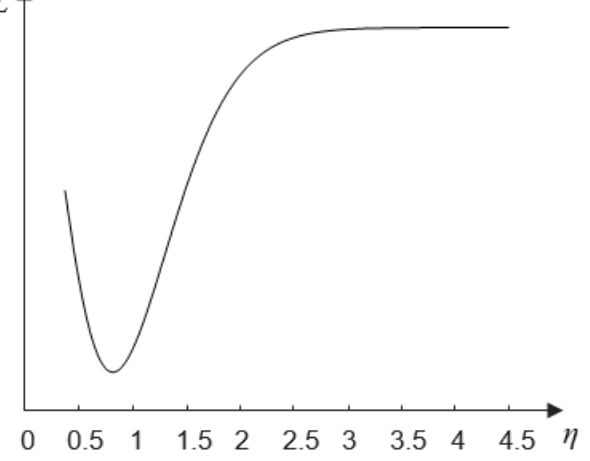
Figure 4. Relationship between average expected loss l and optimal solution η . Substitute the optimal solution into the formula ( USL , LSL ) = ( µ − ησ , µ + ησ ) for the upper and lower limits of the optimal engineering specification, it can be obtained that: The lower limit of the optimal specification for the quality loss part is LSL = µ − ησ = 10 − 0.745 × 2 = 8.51. The upper limit of the optimal specification for the quality loss part is USL = µ + ησ = 10 + 0.745 × 2 =